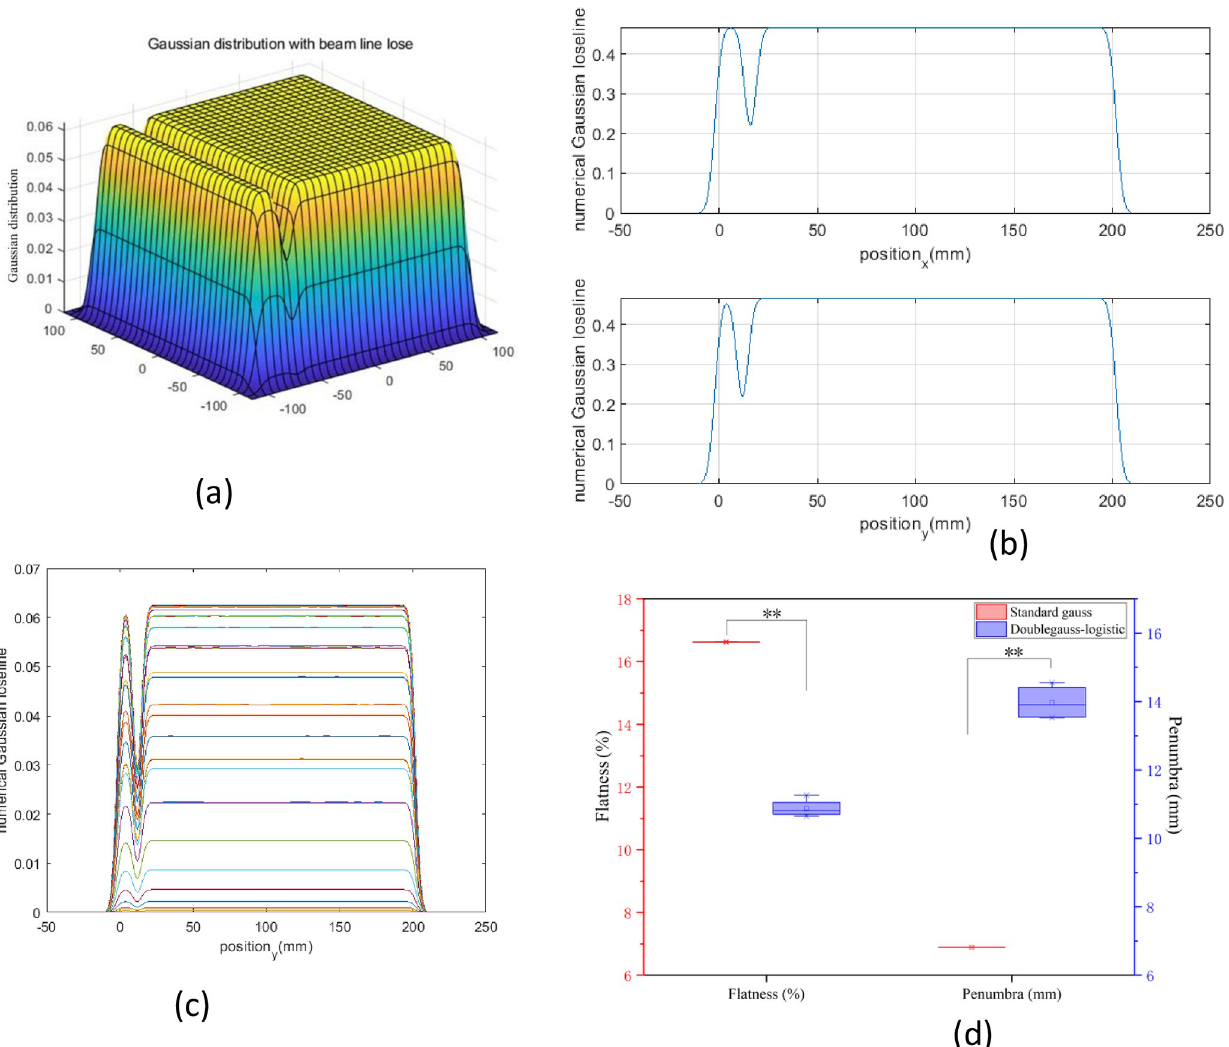
Fig 9. The influence of random loss lines on flatness and penumbra. (a) 3D Gaussian distribution with beam line loss was plotted by MATLAB. (b) and (c) The projection of Gaussian distribution was drawn in both x- and y-directions. (d) The calculated flatness and penumbra were compared in the standard Gaussian model and the double Gaussian-logistic model. p values: �� < 0.01.